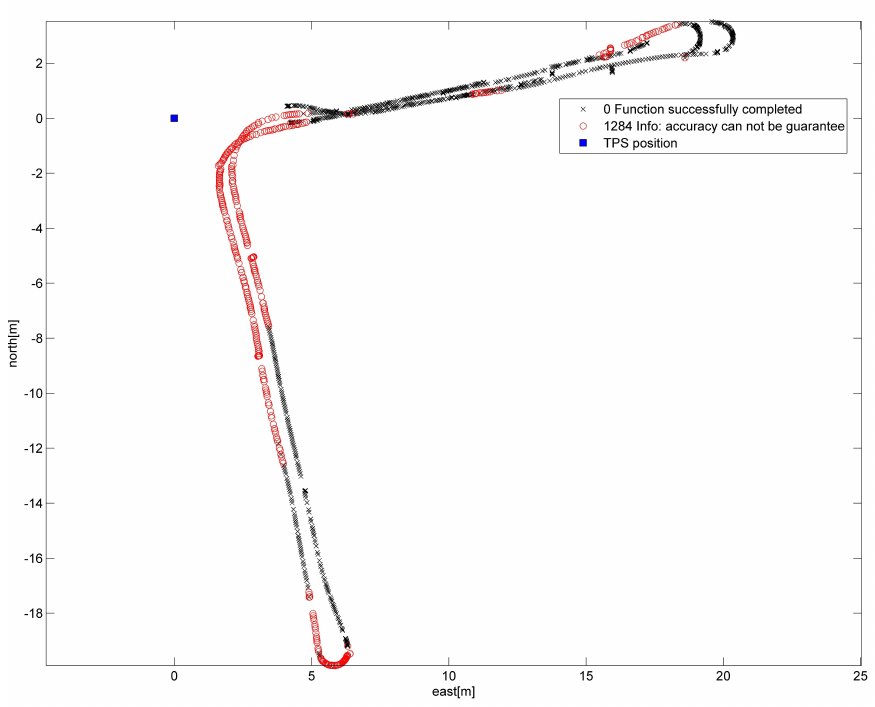
Figure 10. Trajectory 2: all measured points are instantly highlighted by their indexes returned from the total station (0 = OK; 1,284 = accuracy cannot be guaranteed). As expected, code 1284 shows a close range and signal breaks.